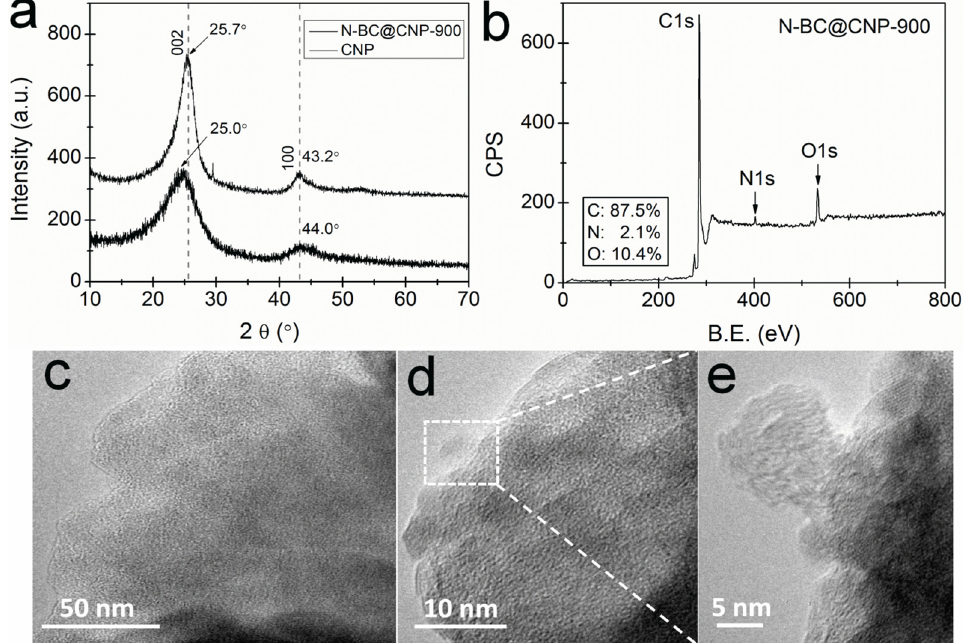
Figure 1. ( a ) The X ‐ ray diffraction (XRD) patterns of carbon nanoparticles (CNP) and N ‐ BC@CNP ‐ 900;